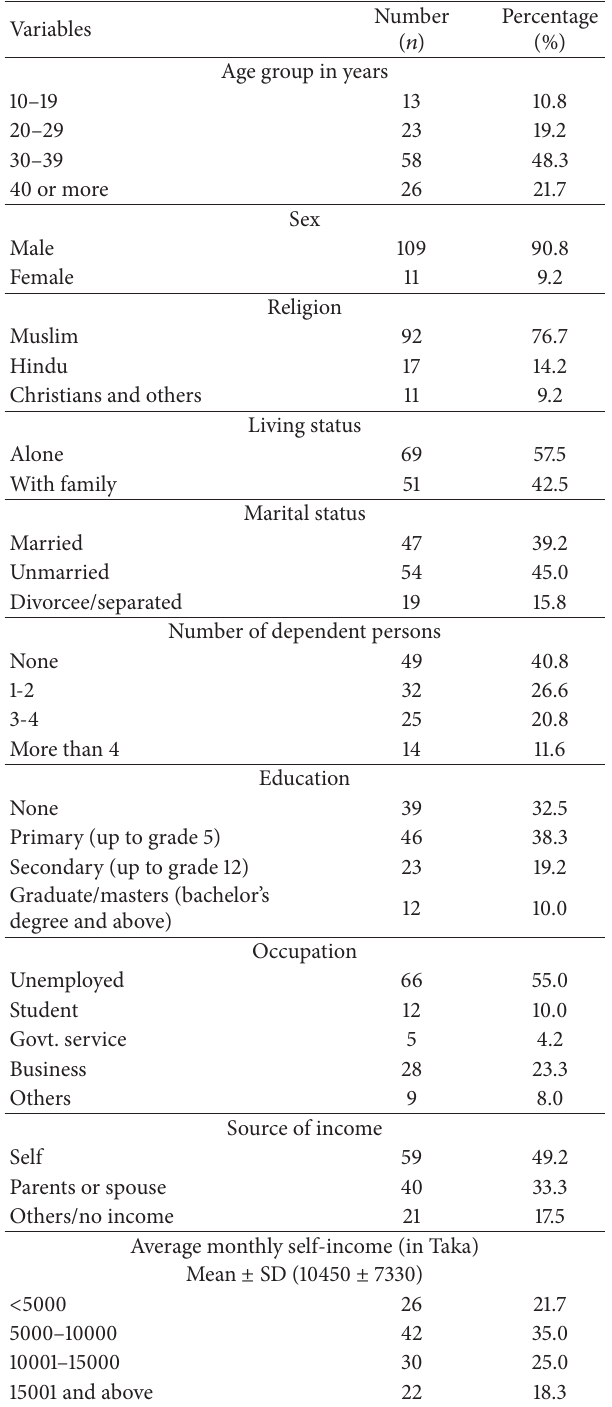
Table 1: Sociodemographic information of the respondents ( 𝑛 = 120